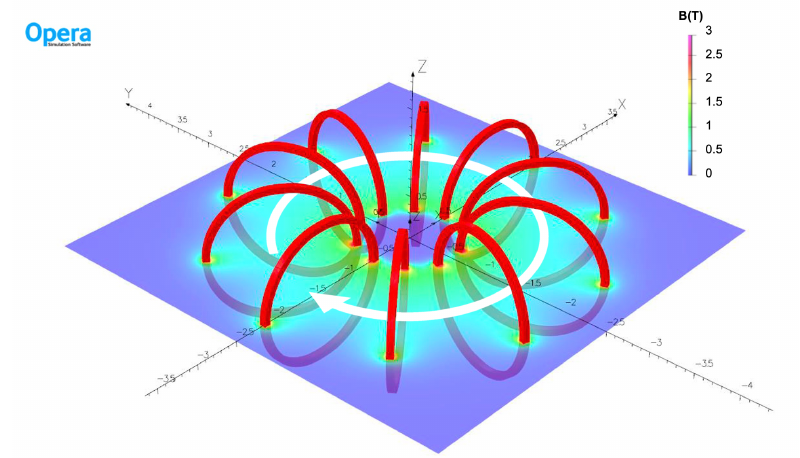
Figure 7. Schematic rendering of the magnet and map of the generated magnetic field in the con- figuration of 10 round coils with the geometry discussed in the text. The field has been simulated using [126]. The white arrow sketches the direction of the magnetic field inside the coils. Figure readapted from[96] under license CC BY